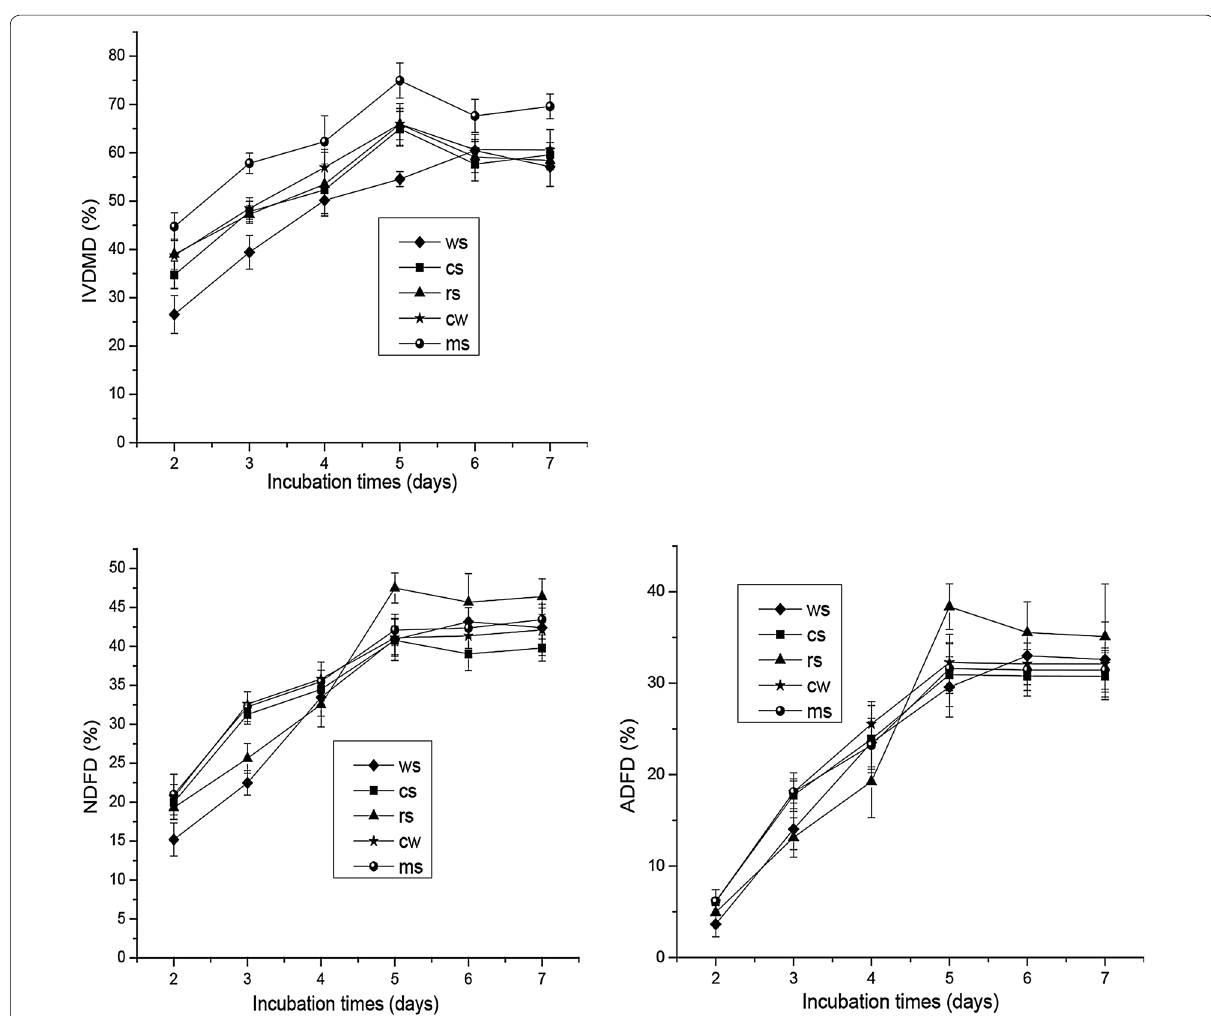
Fig. 2 Fiber degradation by the ( Piromyces M. ruminantium ) Yak‑G18 co‑culture during the 7 days’ incubation ( IVDMD in vitro dry matter digest‑ + ibility, ADFD acid detergent fiber digestibility, NDFD neural detergent fiber digestibility, wheat straw diamond , corn stalk square , rice straw triangle , Chinese wildrye star , medicago sativa circle